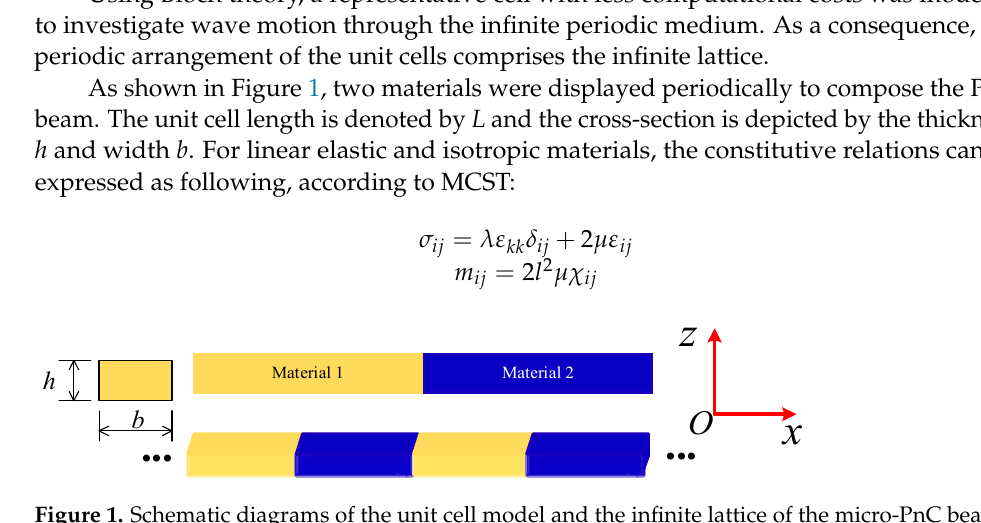
Figure 1. Schematic diagrams of the unit cell model and the infinite lattice of the micro-PnC beam. In Equation (1), λ and μ represent the Lamé constants and l is responsible for measuring the couple stress effects, usually called the material length scale parameter. δ ij , σ ij and m ij denote the Kronecker delta, the Cauchy stress tensor and the deviatoric part of the couple stress tensor, respectively. The infinitesimal strain and the symmetric curvature